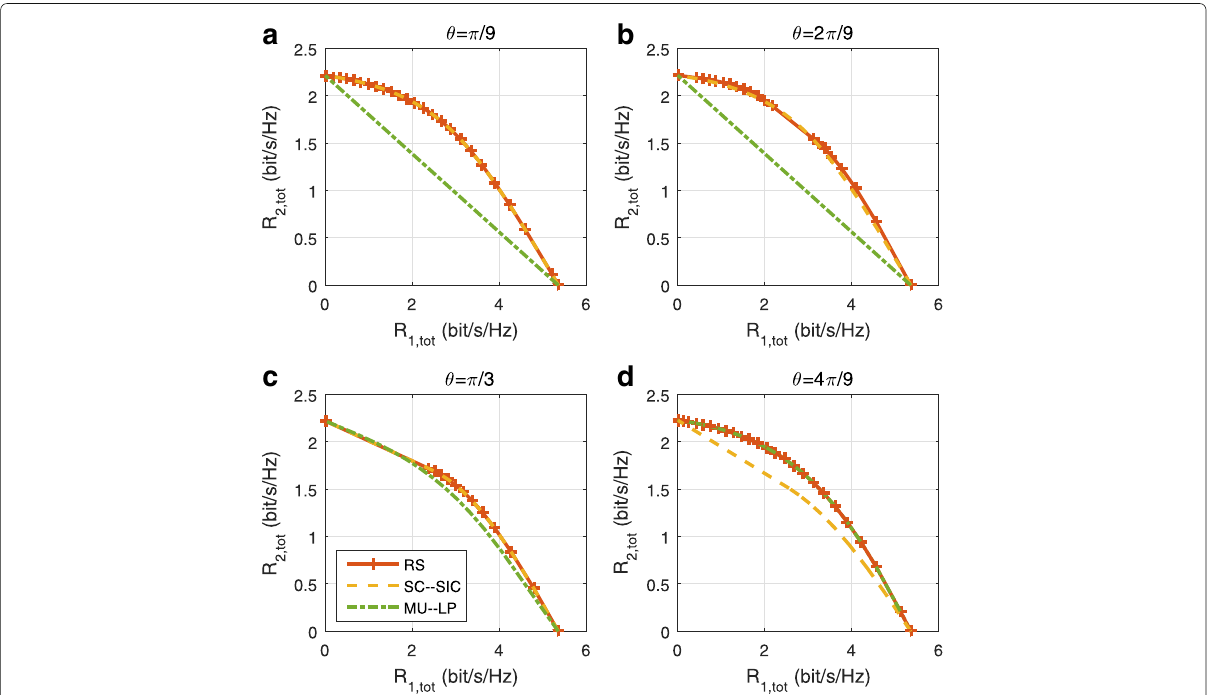
Fig. 27 Average rate region comparison of different strategies in imperfect CSIT, γ = 0.3, N t = 4, SNR = 10 dB. a θ = π/ 9. b θ = 2 π/ 9. c θ = π/ 3.